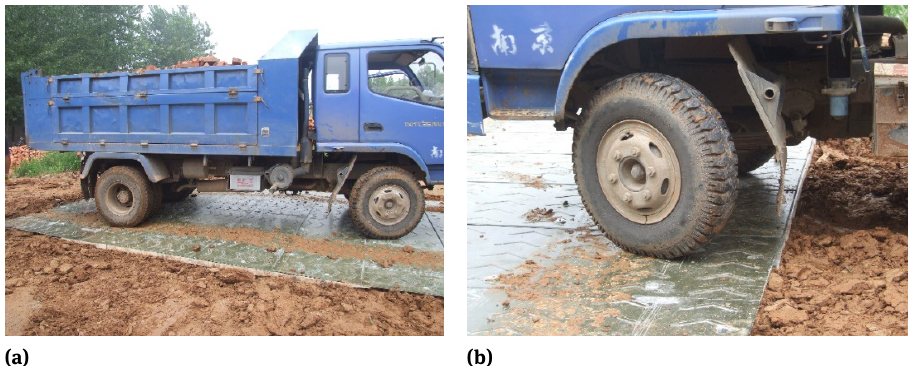
Figure 12: Full-scale tests of the installed matting: (a) load cart test wheel on the middle of the matting; (b) load cart test at the edge of the